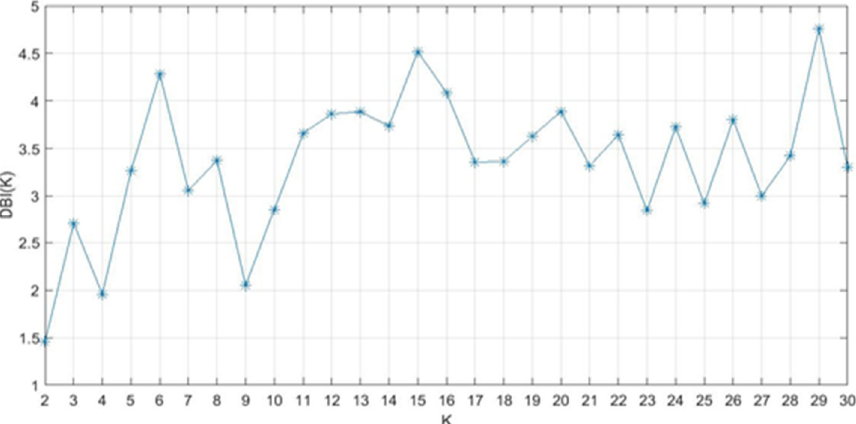
Figure 7. Davies-Bouldin index values for clusters K, showing K = 2 as the minimum.